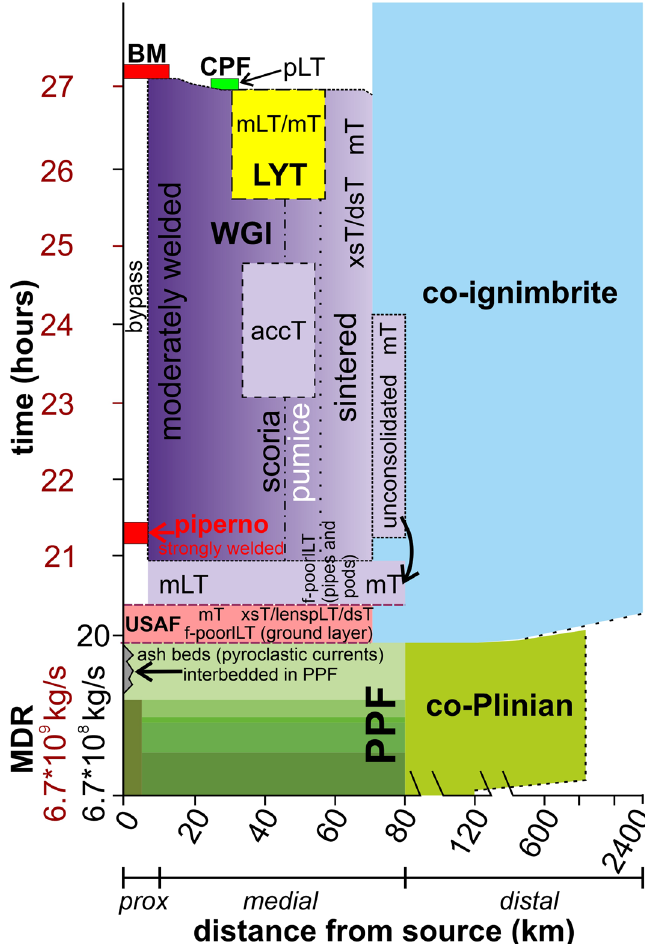
Figure 6. Time-distance plot showing lithofacies architecture of the Campanian Ignimbrite. Pyroclastic current units are deposited during waxing and waning phases. Emplacement time, at increasing distance from the vent, is defined using a cloud spreading velocity of 130 m/s 67 , and a 220 m/s pyroclastic current velocity for the CI current 23 . The values of mass discharge rate refer to the Plinian phase (black) 18 and ignimbritic phase (red) 67 , respectively. Note that due to the time scale chosen and the high velocity of spreading of the products of both phases, the boundaries between the different units are almost horizontal. Only for the distal co-Plinian and co-ignimbrite ashes it is possible to appreciate a diachronic sedimentation. Figure is generated